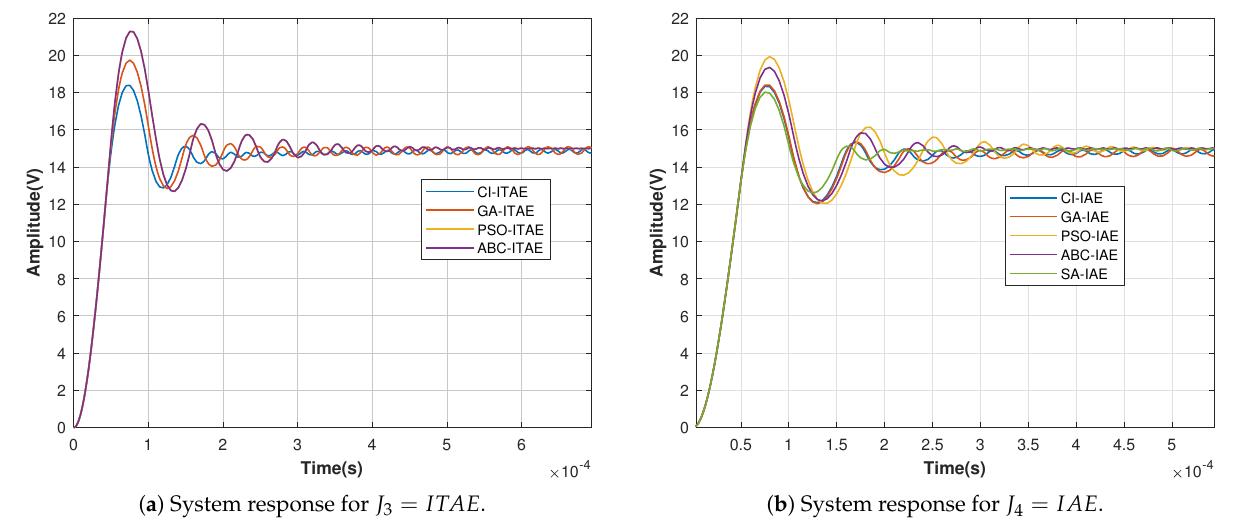
( b ) System response for J 4 = IAE . Figure 15. System response for optimization of ITAE and IAE.